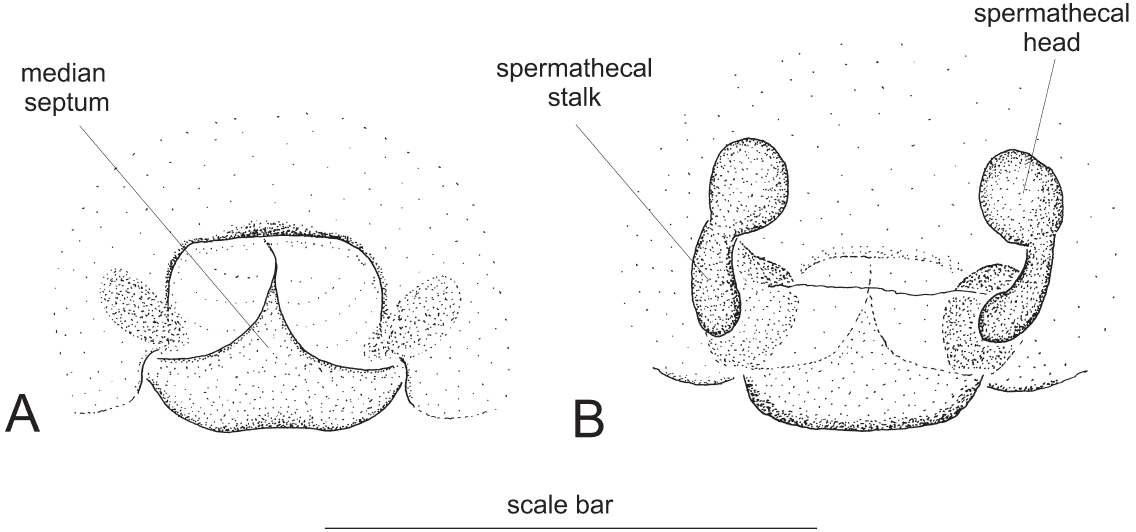
Fig. 8. Tetralycosa caudex sp. nov. A . Epigyne, dorsal view (holotype, ♀, WAM T55570). B . Epigyne, ventral view (♀, WAM T62497). Scale bar: A–B =